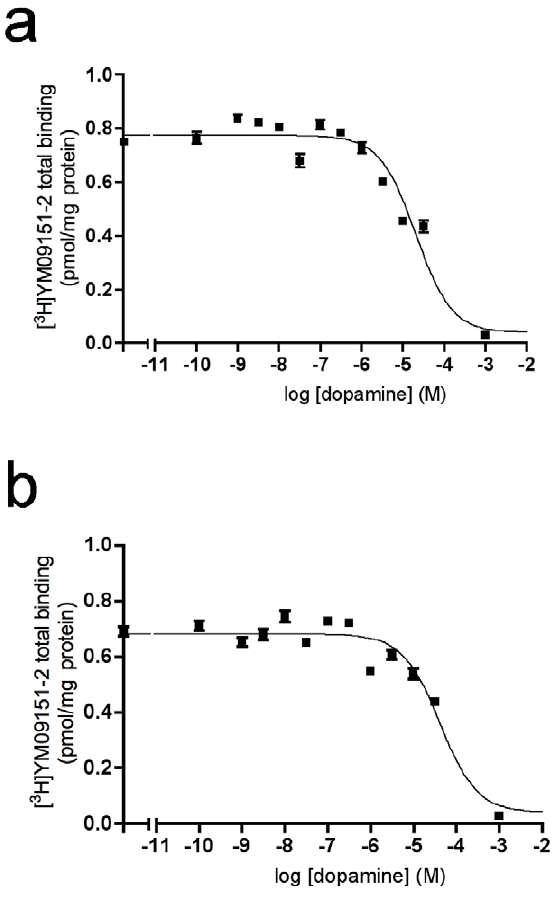
Figure 5. Allosteric interaction between A 2A R and D 2 R in A 2A R- D 2 R CHO cells. Competition experiments were performed in membrane preparations from CHO cells expressing A 2A R and D 2 R with 0.5 nM [ 3 H]YM-09151-2 and increasing concentrations of dopamine (from 0.1 nM to 30 m M) in the absence (a) or in the presence (b) of 200 nM CGS-21680 as indicated in Methods. Data represent means 6 S.E.M. of a representative experiment performed with